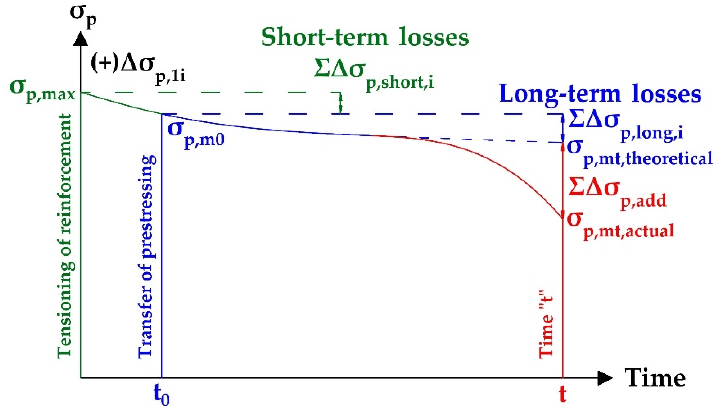
Figure 1. Stress in a prestressing tendon over time.